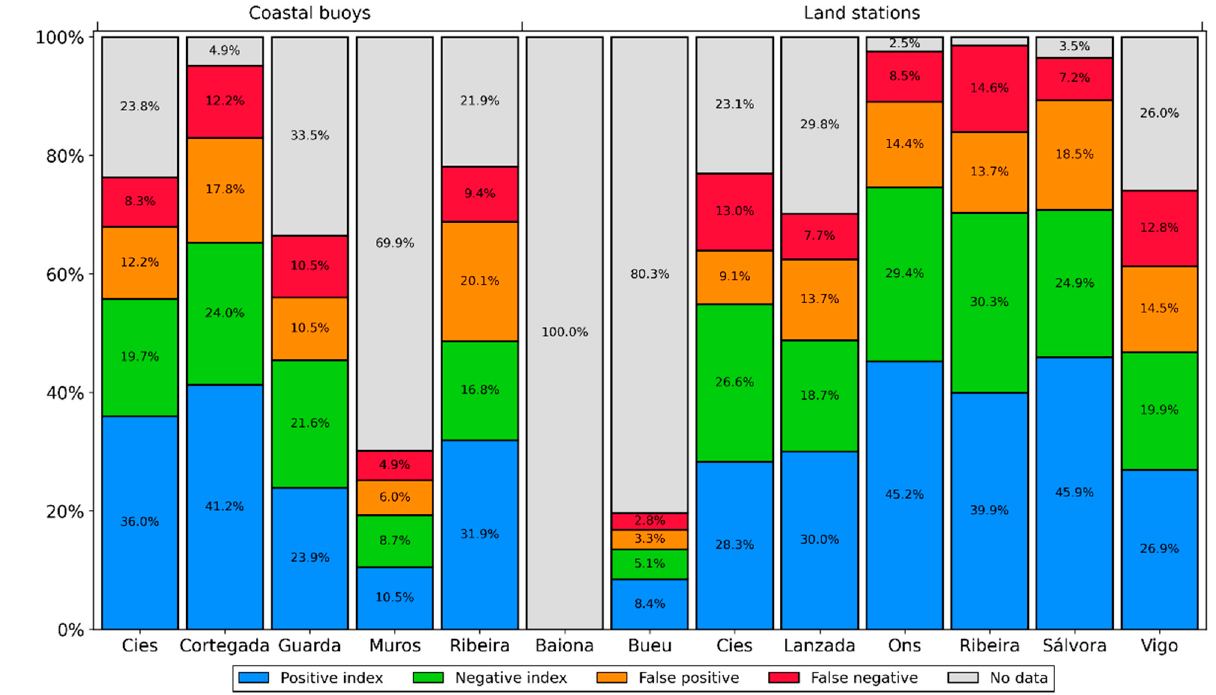
Figure 4. Concordance and divergence of UI between buoy stations and MeteoGalicia model, including the data availability.